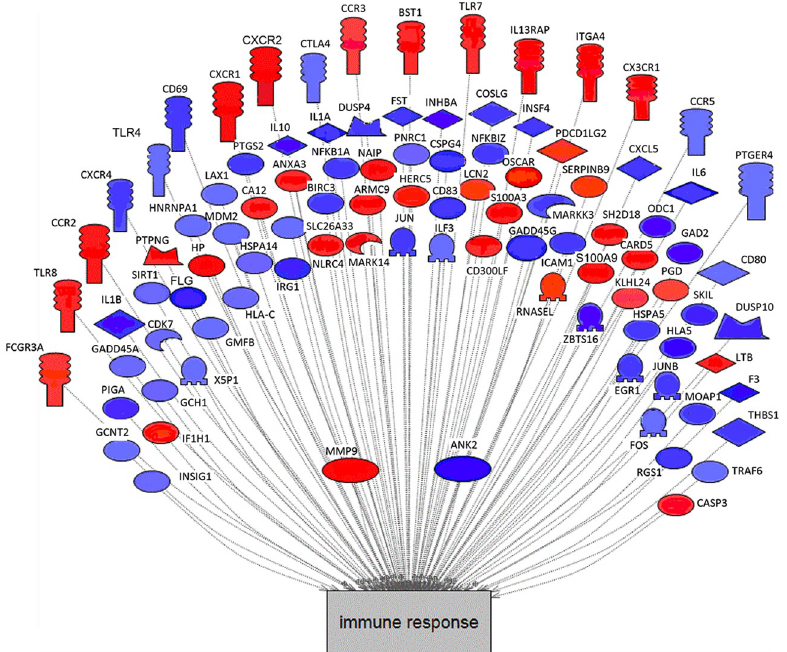
Fig 2. Subnetwork enrichment analysis performed using the software program PathwayStudio ™ illustrating genes that were altered in white blood cells in relation to immune response in manatees affected by red tide compared to control manatees. Red indicates up-regulation and blue indicates down-regulation of gene expression. The intensity of the color is proportional to the degree of up or down-regulation. See S2 File for symbol definitions.